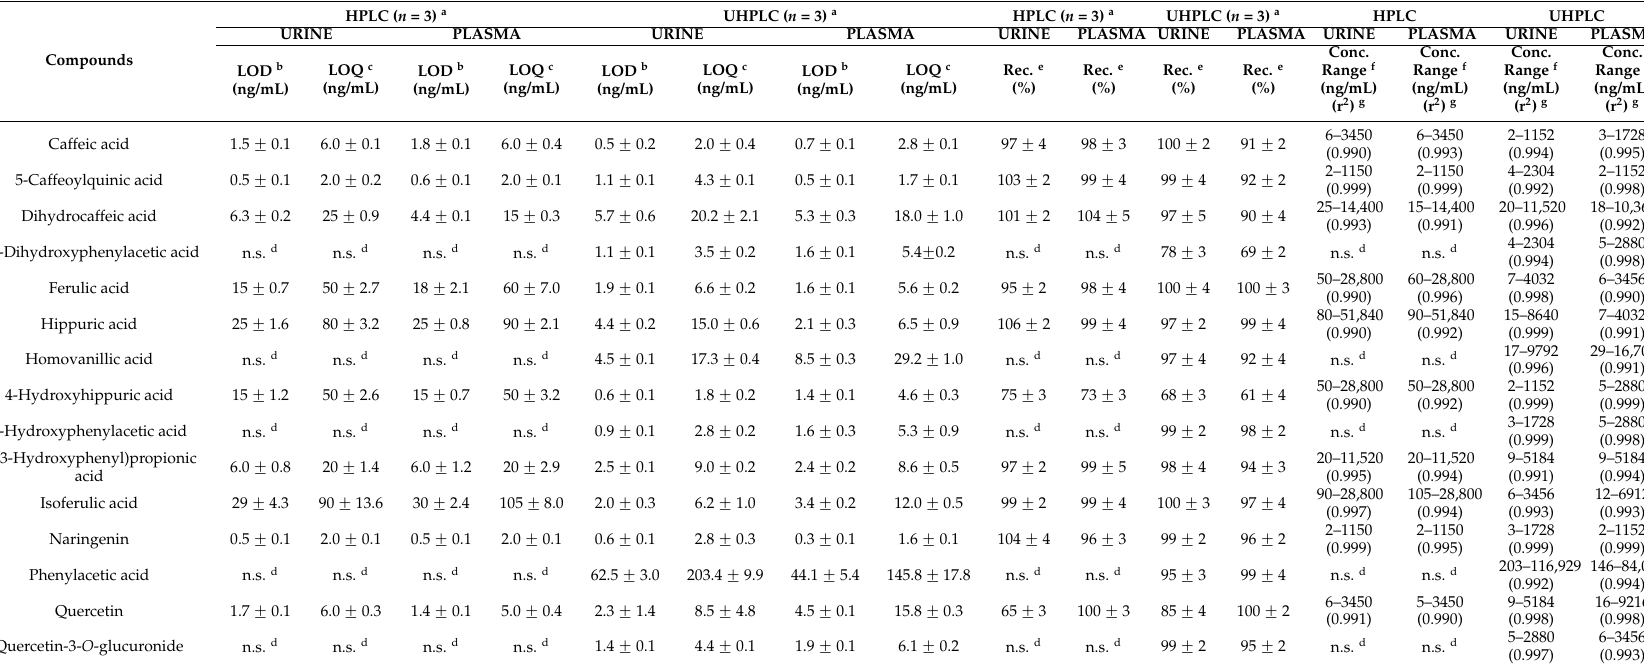
Table 3. LOD, LOQ, recovery, concentration range and correlation coefficient in urine and plasma samples by HPLC-MS/MS and